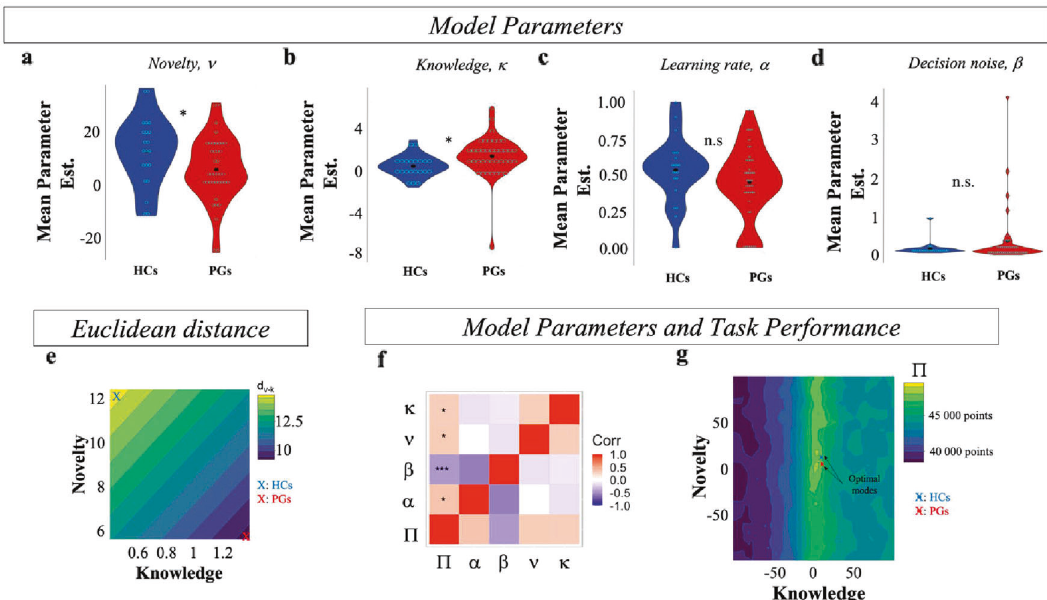
Fig. 4 nkRL parameters and information-seeking modes. Model fi t on all free-choice trials revealed a decrease in the novelty parameter ν in PGs compared to HCs ( a ), while the knowledge parameter κ was higher in PGs compared to HCs ( b ). Learning rate α ( c ) and decision noise β ( d ) did not differ between the two groups. e The Euclidean distance d v-k between κ and ν was larger in HCs (in blue) than in PGs (in red). f Correlation matrix between nkRL model parameters and task performance Π . P -values are corrected for multiple comparisons (FDR). Both ν and κ positively correlated with Π . Only correlations between Π and model parameters are reported. g Performance Π across ν and κ parameter space. The averaged values of ν and κ for HCs are shown in blue, while in red for PGs. The two averaged values are expressed closer to the two optimal modes (in yellow) (color fi gure